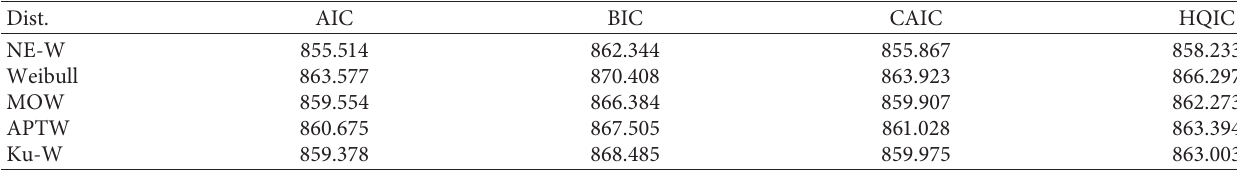
Table 4: The analytical measures of the fitted models for data 1.